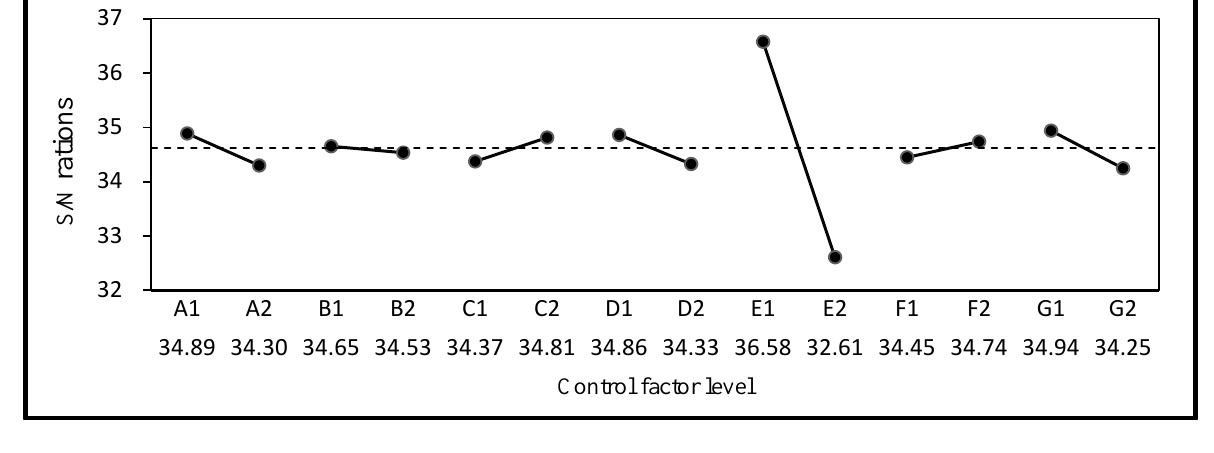
Figure 3. S/N ratio response graph for